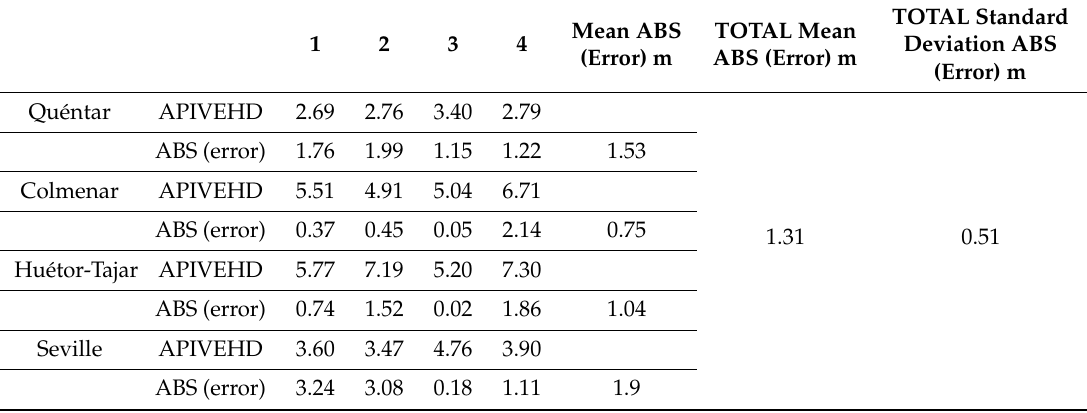
Table 8. PIVED after applying the scale factor (APIVED). Medium interrogation window.